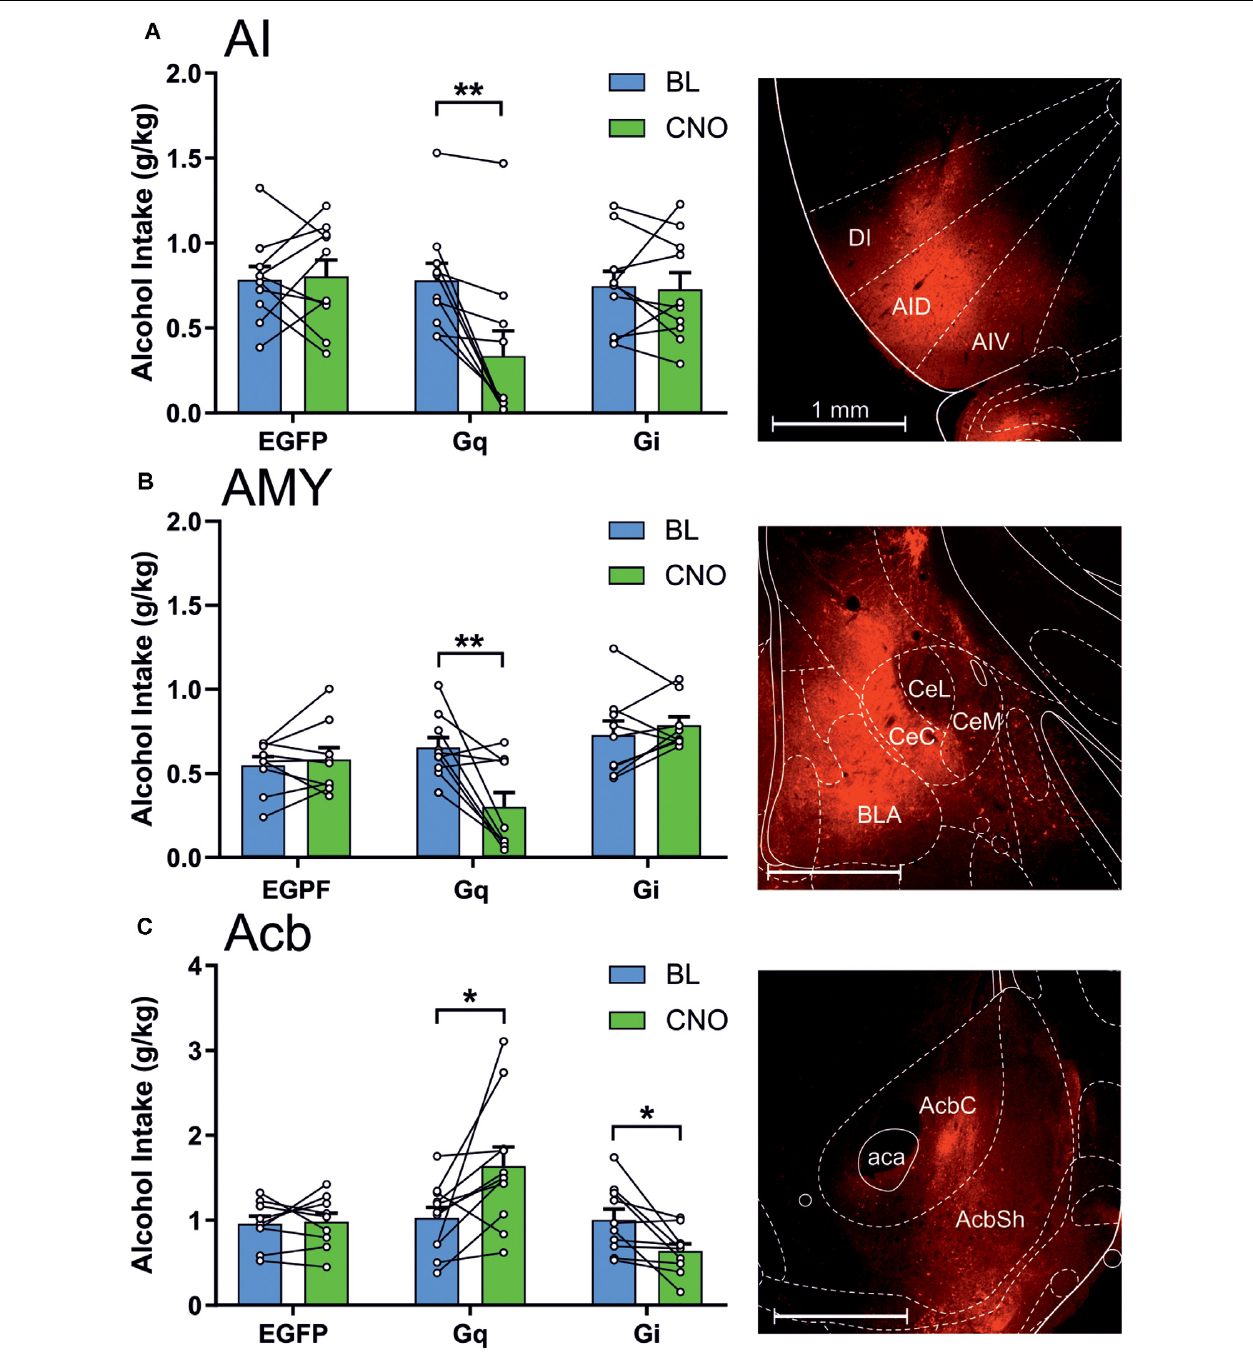
FIGURE 3 | Chemogenetic stimulation and inhibition have differential effects on alcohol drinking in the anterior insula, amygdala, and nucleus accumbens. The data are expressed as mean ± SEM alcohol intake (g/kg) during 2-h sessions during the baseline (BL) and following a clozapine-N-oxide (CNO) injection in three separate treatment groups expressing enhanced green fluorescent protein (EGFP), Gq-designer receptors exclusively activated by designer drugs (Gq-DREADDs), or Gi-DREADDs in each brain area. (A) EGFP ( n = 10), Gq-DREADDs ( n = 10), and G-DREADDs ( n = 10) expressed in the anterior insula. (B) EGFP ( n = 9), Gq-DREADDs ( n = 10), and G-DREADDs ( n = 9) expressed in the amygdala. (C) EGFP ( n = 9), Gq-DREADDs ( n = 11), and G-DREADDs ( n = 10) expressed in the nucleus accumbens. Each histogram is accompanied by a representative brain section expressing Gq-DREADD-tagged mCherry reporter. * p < 0.05, ** p < 0.01, paired t -tests comparing the BL and CNO sessions. Abbreviations used: DI, dysgranular anterior insula; AID, agranular anterior insula, dorsal; AIV, agranular anterior insula, ventral; CeC, central amygdaloid nucleus, capsular division; CeL, central amygdaloid nucleus, lateral division; CeM, central amygdaloid nucleus, medial division; BLA, basolateral amygdala; AcbC, nucleus accumbens core; AcbSh, nucleus accumbens shell; aca, anterior commissure.